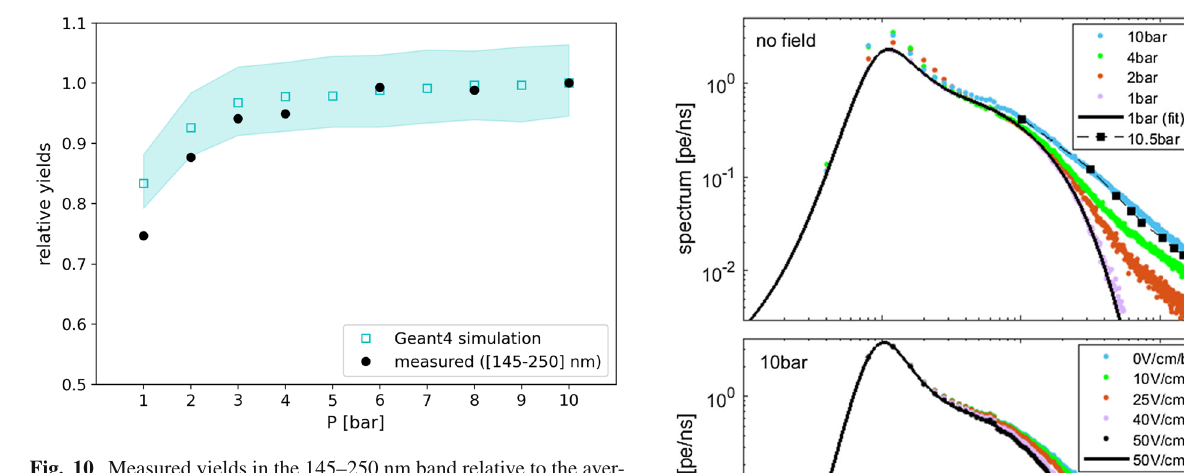
3 Results for primary scintillation (S1)